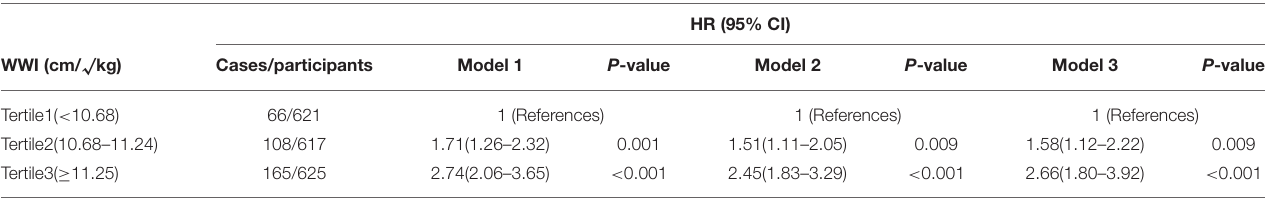
TABLE 2 | Cox regression analyses for the association between all-cause mortality and weight-adjusted waist